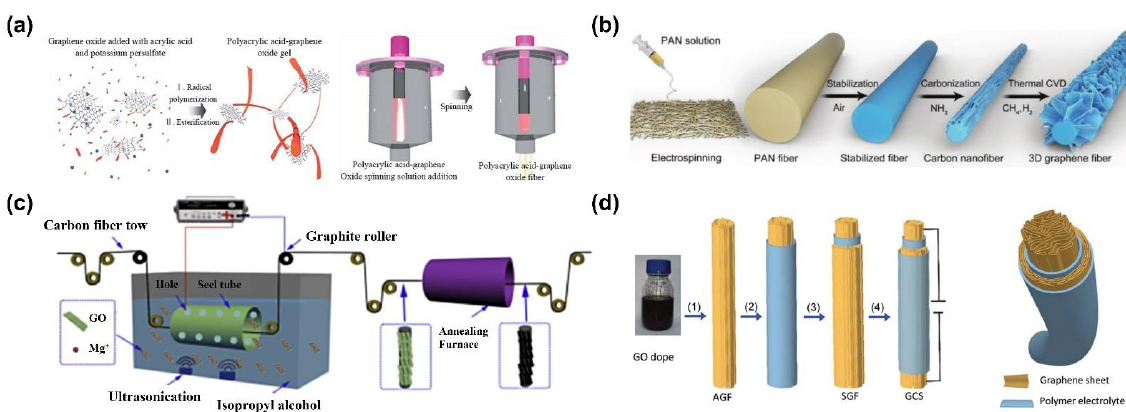
Figure 3. ( a ) Preparation of GO/PAA gels where the PAA is in situ polymerized in GO aqueous solution, and subsequent spinning of composite fibers [84] (copyright permission Royal Society of Chemistry 2013); ( b ) Preparation of composite fibers by thermal CVD growth of graphene on electrospun PAN nanofibers [89] (copyright permission Wiley-VCH 2017); ( c ) The scheme of EPD deposition of GO onto carbon fiber surfaces [90] (copyright permission Elsevier 2016); ( d ) Schematic illustration of the fabrication process of a graphene coaxial fiber supercapacitor via wet-spinning, chemical reduction and multiple dip-coating of polymer electrolyte and GO gel [91] (copyright permission Royal Society of Chemistry 2015). Table 1. Preparation of different graphene-based composite fibers. Electrodes Prepration Methods Electrolyte Agents Time/Temperature